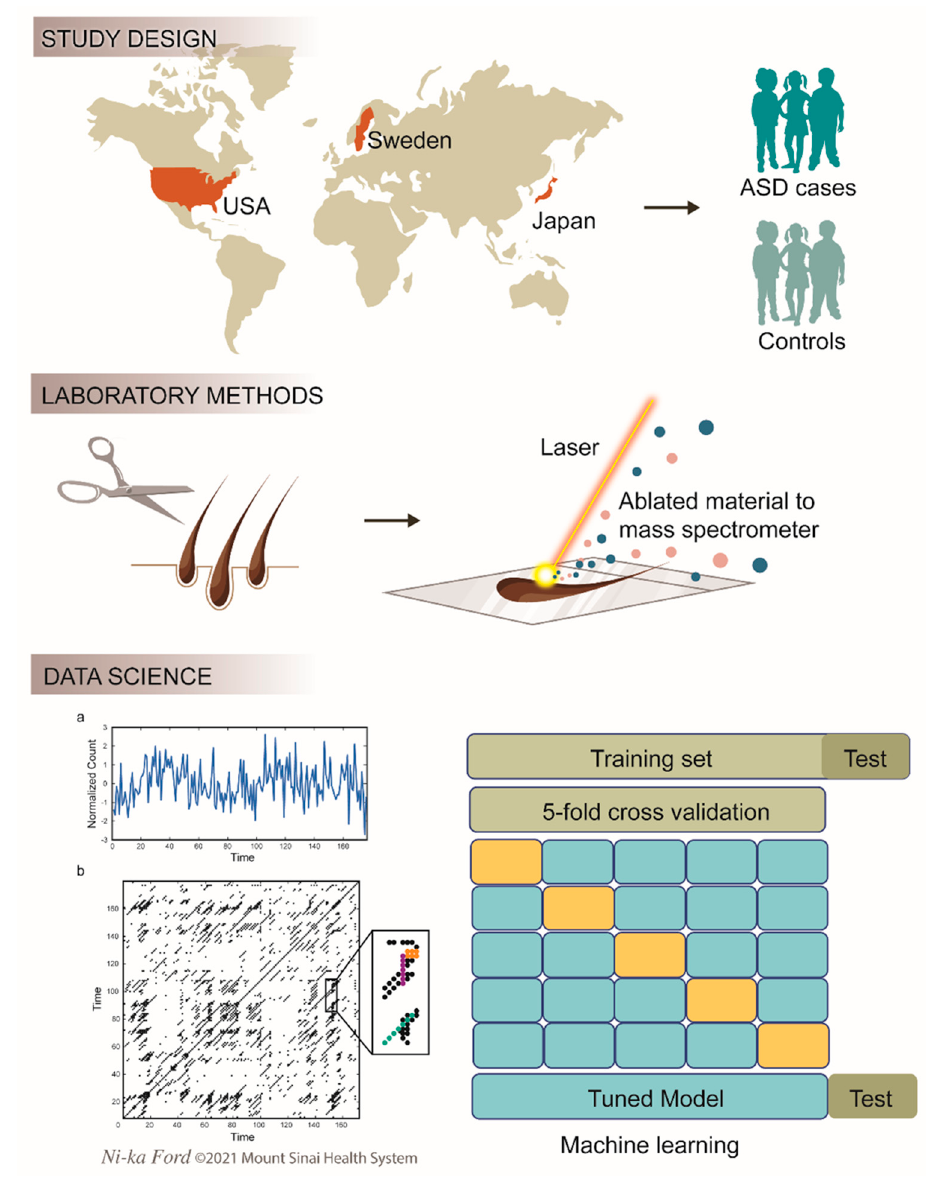
Figure 1. Study design and analytical pipeline. ( a ) Participants were recruited in Japan (prospective national study), Sweden (cross-sectional national study), and New York (cross-sectional, single-clinical-center study). Clinical case ascertainment was undertaken using DSM-5 criteria (Autism Spectrum Disorder, ASD). Scalp hair strands were analyzed using laser ablation-inductively coupled plasma-mass spectrometry to generate 4 to 6 hourly profiles of elemental uptake. ( b ) Recurrence and cross-recurrence quantification analyses were used to quantify the dynamic nature of elemental assimilation. A machine learning algorithm was trained on 80% of the data and tested on a randomly selected 20% holdout